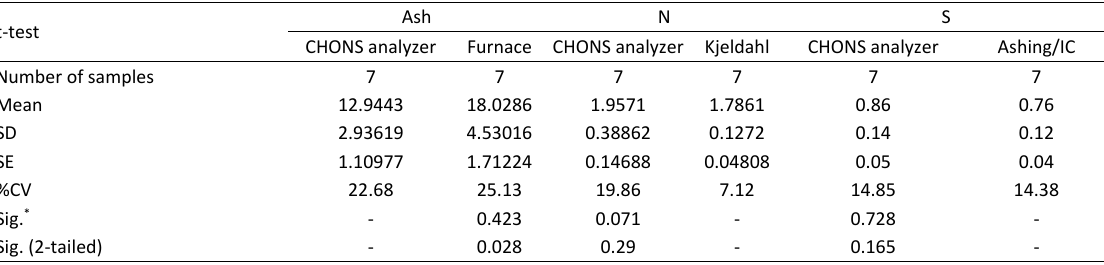
Table 5: Comparing the laboratory methods by independent samples t-test